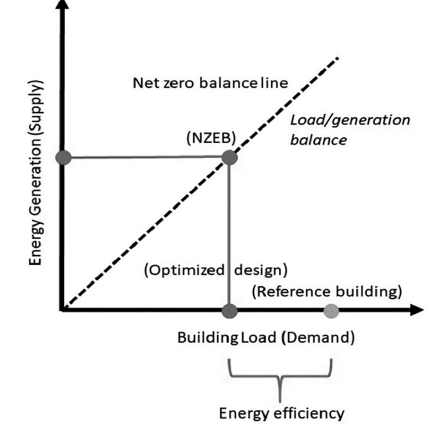
Figure 2. The Graphic expression of NZEB (Sartori et al.,